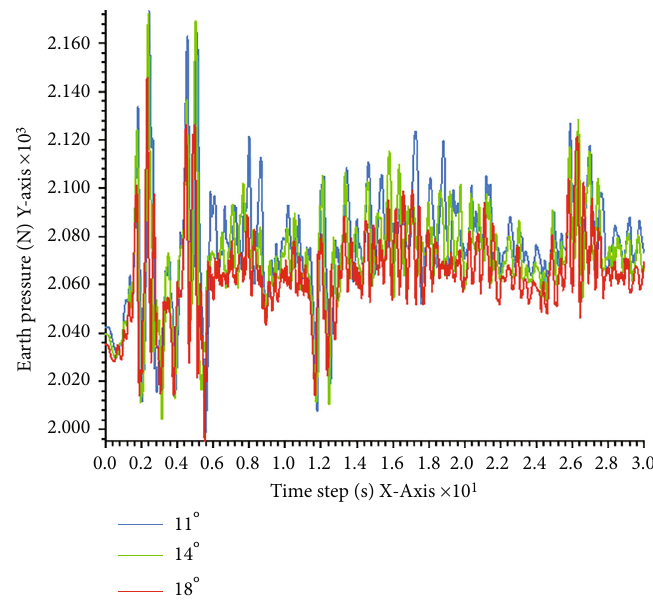
Figure 11: Distribution of the anchor cable axial force under di ff erent anchor angles.